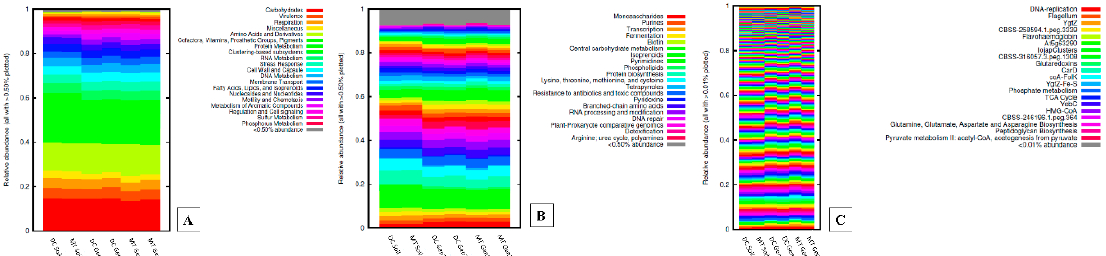
Figure 4. Gene functions identified from the SRS soils relative to different generations of DC/MT binned at subsystem levels 1 ( A ), 2 ( B ), and 3 ( C ), respectively.